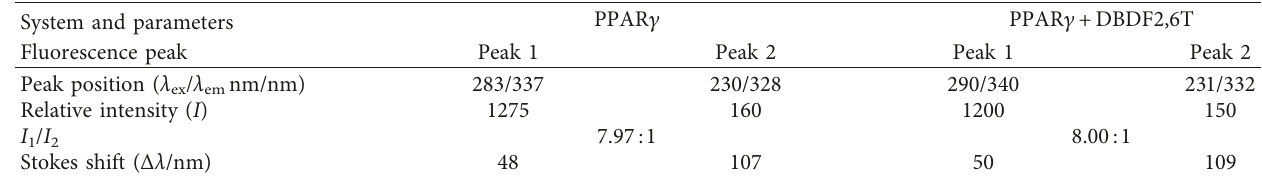
Figure 5: The contour maps of two florescent systems: (a) hPPAR c and (b) hPPAR c -DBDF2,6T system ( T Table 4: Several characteristic parameters of 3D fluorescence experiments.